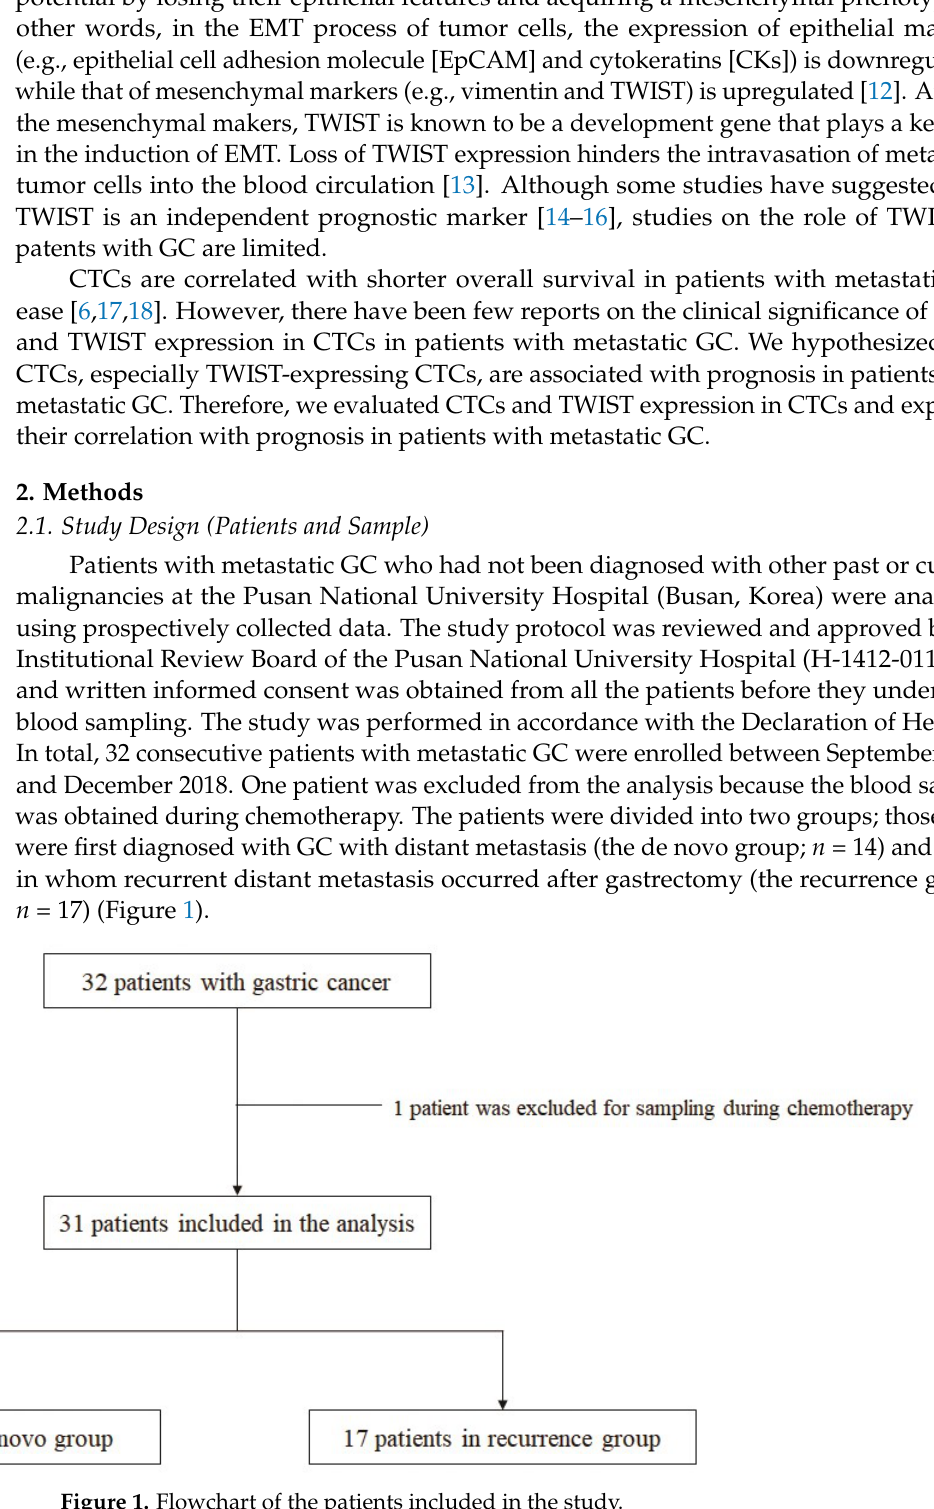
Figure 1. Flowchart of the patients included in the study.